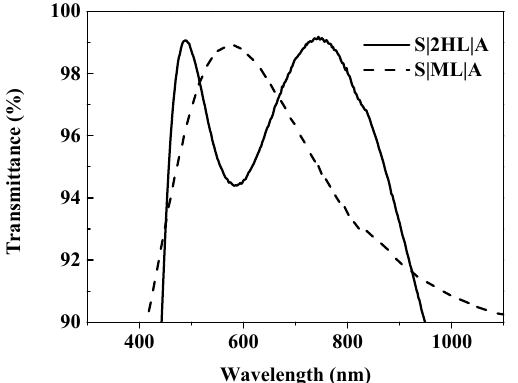
Figure 9. Experimental transmittance spectra of λ / 2- λ / 4 (S | 2HL | A) and λ / 4- λ / 4 (S | ML | A) double-layer AR coatings. The layers M, H and L are T33S67, Nb 2 O 5 and SiO 2 , respectively. Both the two AR coatings were prepared via the dip-coating method.